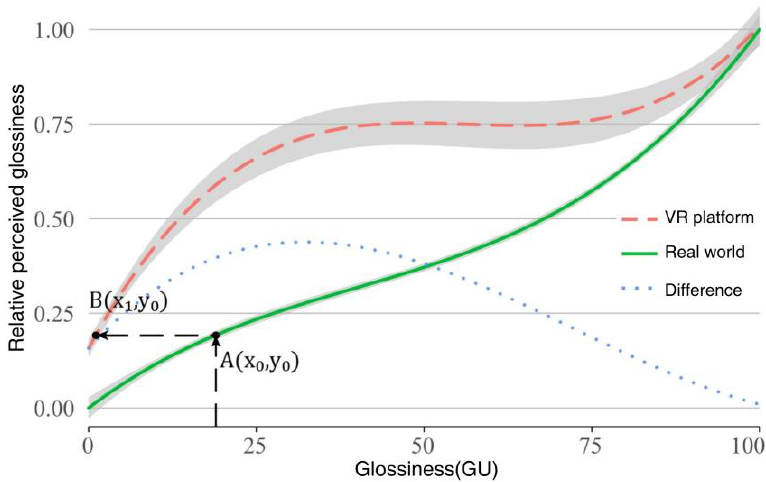
Figure 10. The mapping curve between physical glossiness (GU) and relative perceived glossiness.